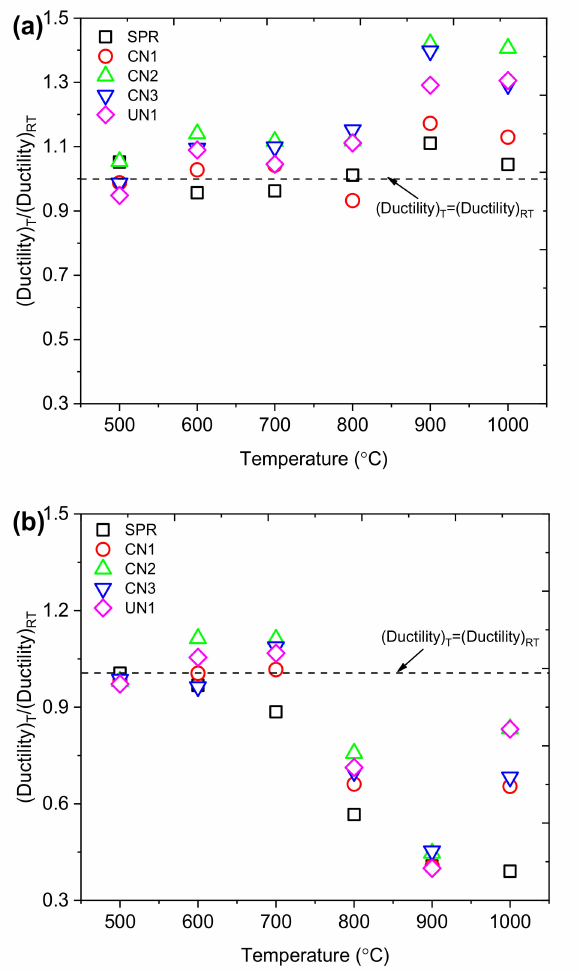
Figure 10. Ductility residual factors of the test specimens, ( a ) cooled in air, and ( b ) cooled in water.